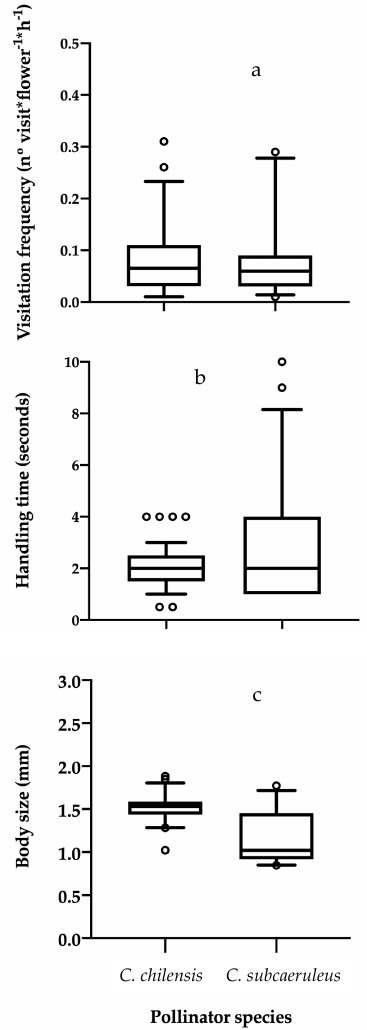
Figure 2. Pollinators’ functional traits measured in two oil-collecting bees. ( a ) Visitation frequency, ( b ) handling time and ( c ) body size. All values represent mean ± standard error.